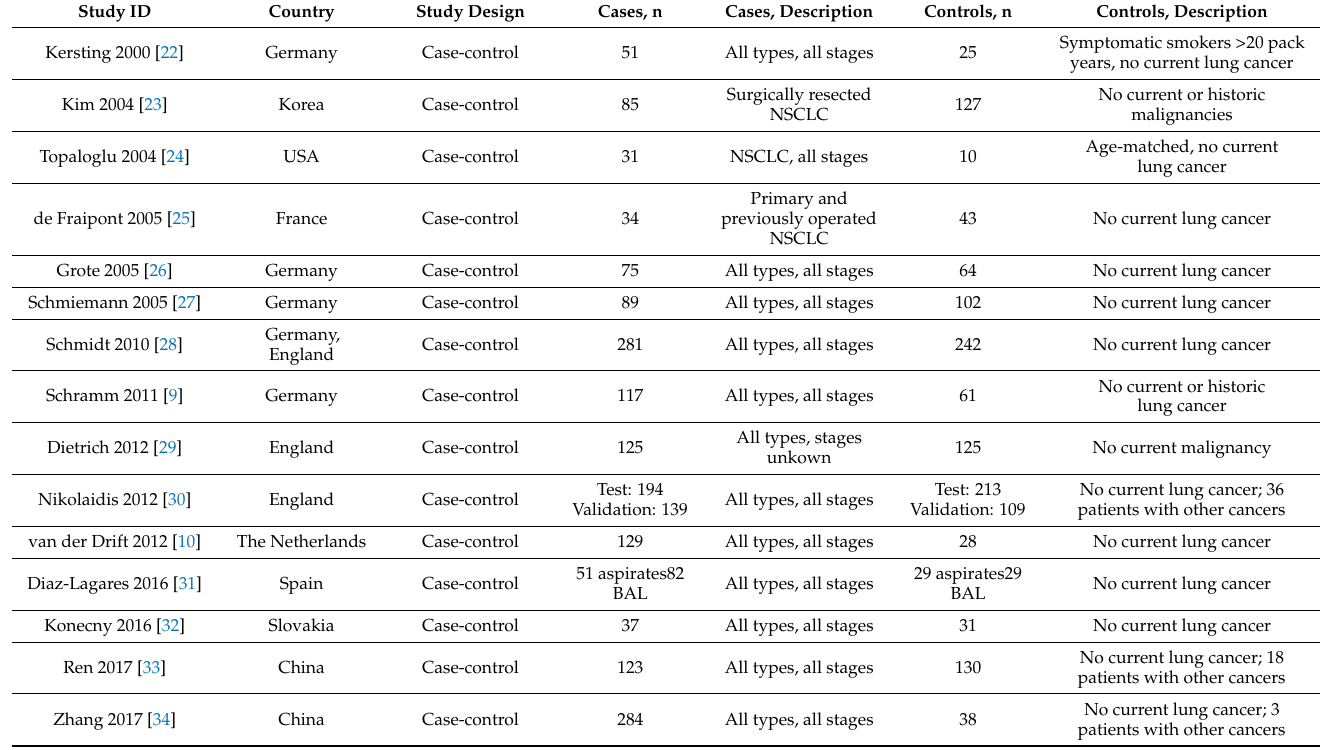
Table 1. Four studies were divided into test and validation cohort, and one study had separate cohorts for bronchoalveolar lavage (BAL) and bronchial aspirates. The case description ‘All types’ covers both small-cell lung cancer and non-small-cell lung cancer (NSCLC). The case description ‘All stages’ covers the tumor, node, and metastasis (TNM) stages